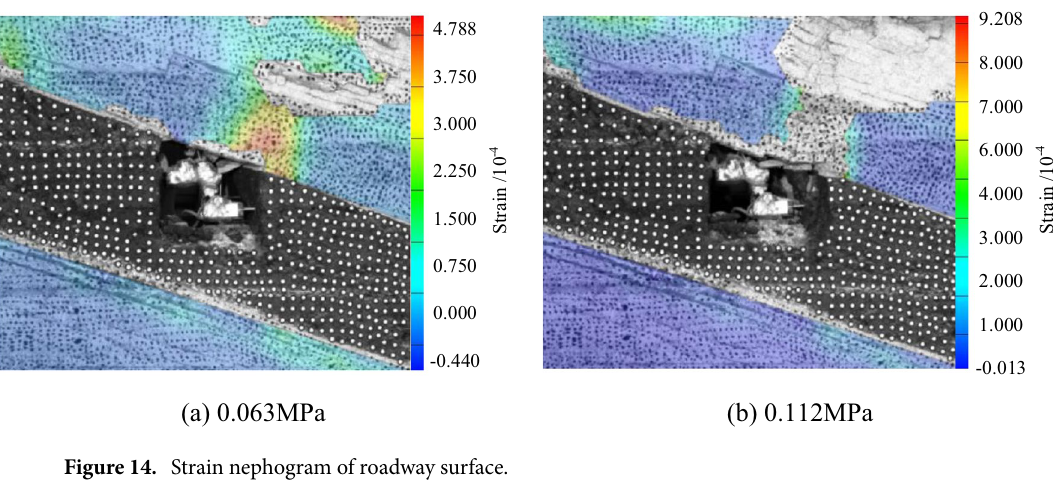
Figure 14. Strain nephogram of roadway